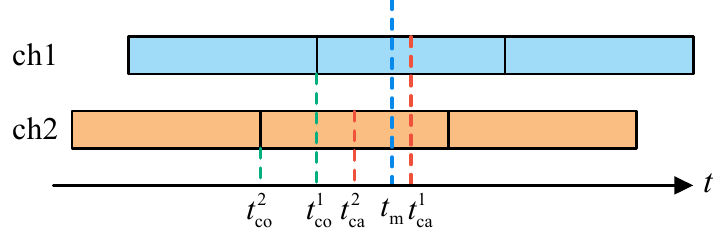
Figure 7. Diagram of pseudorange rate measurement process.